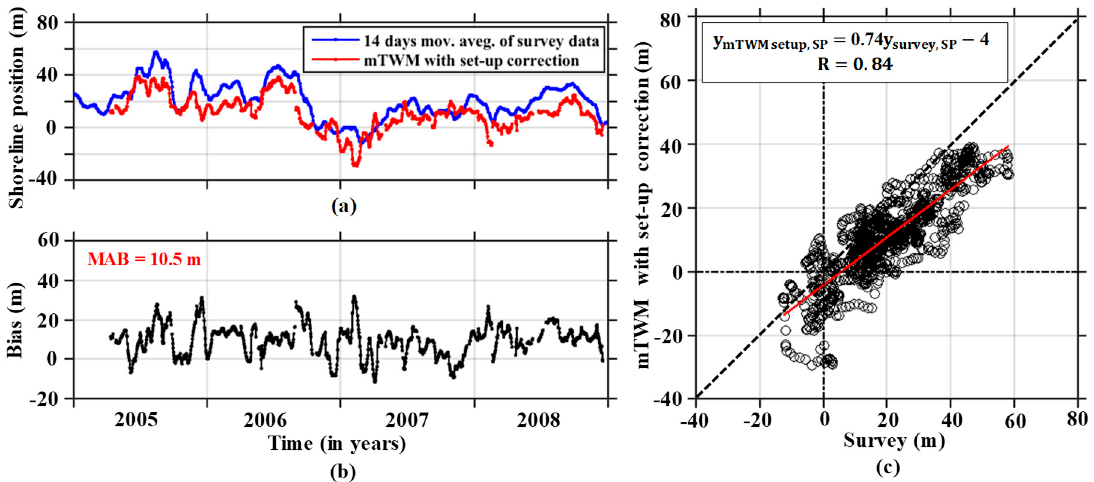
Figure 18. ( a ) The temporal variations in shoreline position (SP) estimated from survey data and mTWM derived results with corrected wave set-up (at x = − 49 m). ( b ) The bias between the survey data and mTWM-derived results with corrected wave set-up. ( c ) The scatter plot of the survey vs. mTWM with corrected wave set-up. The red line represents the linear fitting line.